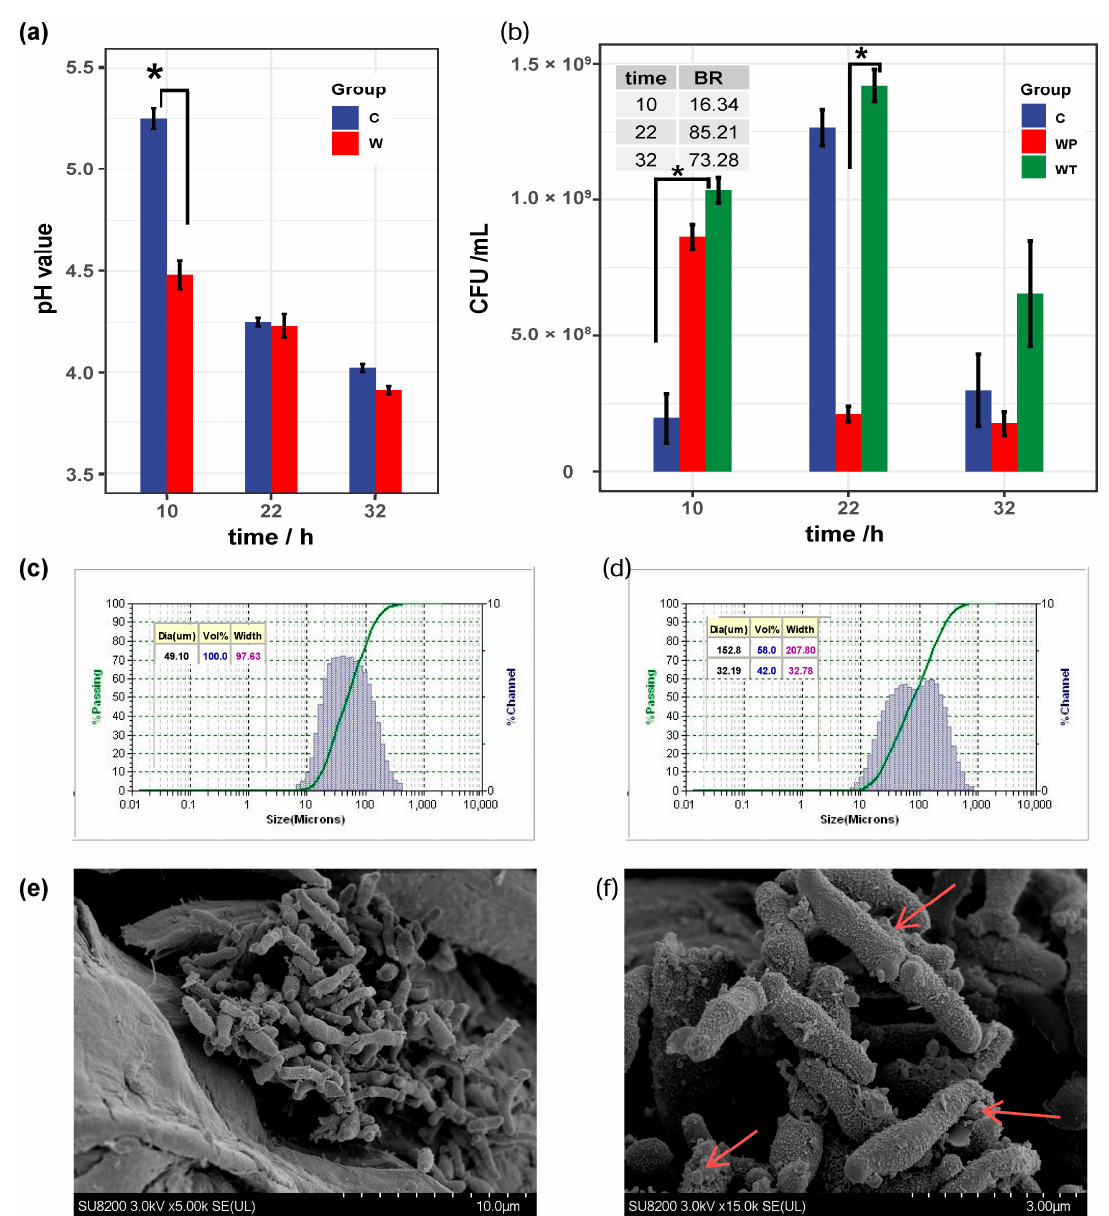
Figure 1. B. bifidum FHB150 form biofilm on WF. WF: wheat fiber. ( a ) pH values of WF culture and control culture. Significance is expressed in comparison with the controls at the same time (* p < 0.05 are significantly different). ( b ) Cell number of WF culture and control culture. WT: Total cell number in WF culture. WP: Planktonic cell number in EF culture; C: Cell number in control culture; BR: biofilm rate; BR = (WT − WP)/WT * 100%. ( c ) Particle size of noninoculated WF. ( d ) Particle size of inoculated WF at 22 h. ( e ) FESEM of biofilm on WF at 22 h, 5000 × . ( f ) FESEM of biofilm on WF at 22 h, 15,000 × ; the presence of EPSs is indicated by red arrows. EPSs: extracellular polymeric